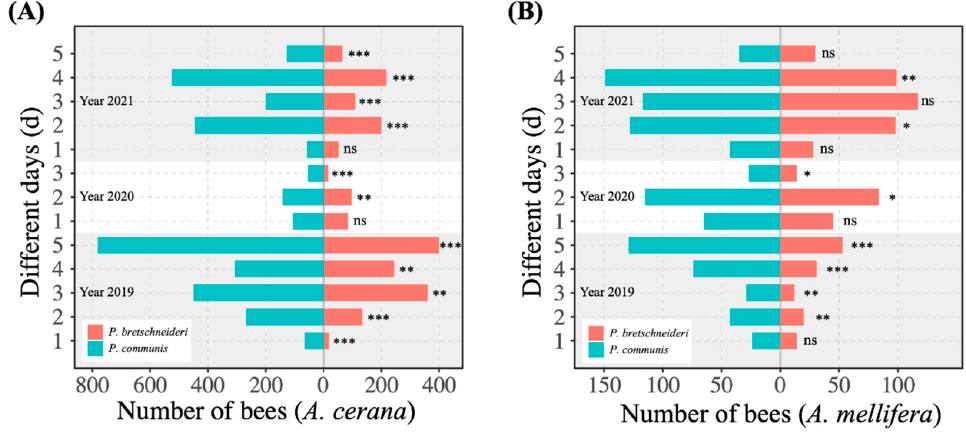
Figure 2. The daily foraging choices of honey bees. ( A ) Choices of A. cerana ; ( B ) choices of A. mellifera